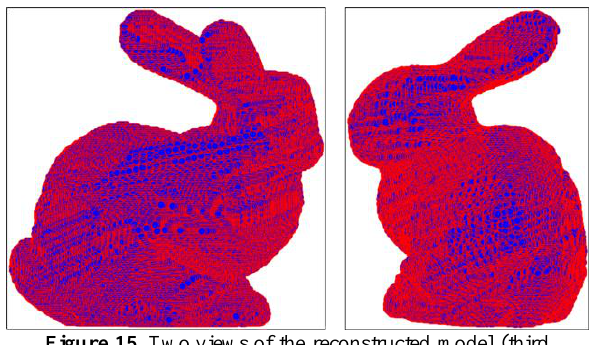
Figure 15. Two views of the reconstructed model (third experiment) The reconstruction model has been compared to the Computer- Aided Design (CAD) in Figure 16. This CAD model was used to 3D print the object, and therefore it is an accurate representation of the object. Figure 16 (a) shows the selected view of the reconstruction. The mesh model of the reconstruction, the ground-truth model, and the superimposed models are shown in Figures 16 (b), 16 (c), and 16 (d), respectively.